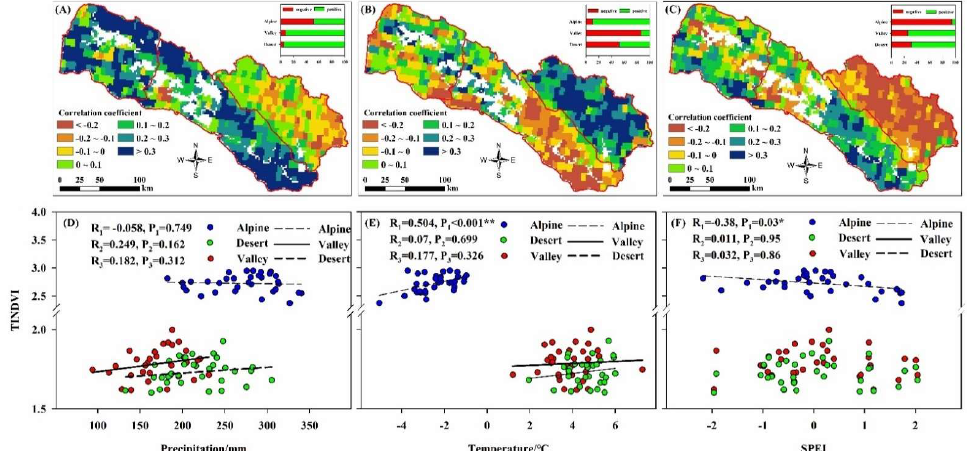
Figure 7. Correlation between precipitation, temperature and SPEI and TINDVI. Note: ( A – C ) show the spatial distribution of correlation coefficient between precipitation, temperature and SPEI and TINDVI. Further, the histogram in ( A – C ) show the proportion of positive and negative correlations. ( D – F ) show the temporal correlation between annual precipitation, annual temperature and annual SPEI and annual average of TINDVI. R 1 , R 2 and R 3 value in alpine, valley and desert are shown in each plot. So is the p value. * p < 0.05, ** p < 0.01. The trend changes of NDVI and meteorological factors on the monthly scale (Figures 3 and 5) found that the increase of NDVI in the Irtysh River basin on the time series was mainly due to the advancement of the growing season and the extension of the growing period. The results validate the physiographic view that the positive correlation between plant productivity and growing season duration [41,42]. Furthermore, it is interesting that the growth peak of NDVI in the whole watershed occurs in spring and autumn rather than summer, from March to May, NDVI growth reached its first peak ( p < 0.05) i.e., the re-greening stage of plants, during the same period, where precipitation showed a signif- icant increasing trend ( p < 0.05), and the temperature from January to March showed a significant increasing trend ( p < 0.05), which indicates that moisture and temperature in early spring are the dominant climatic factors in plant re-greening period in the study area. The accumulation of temperature in the early stage and the increase of available wa-